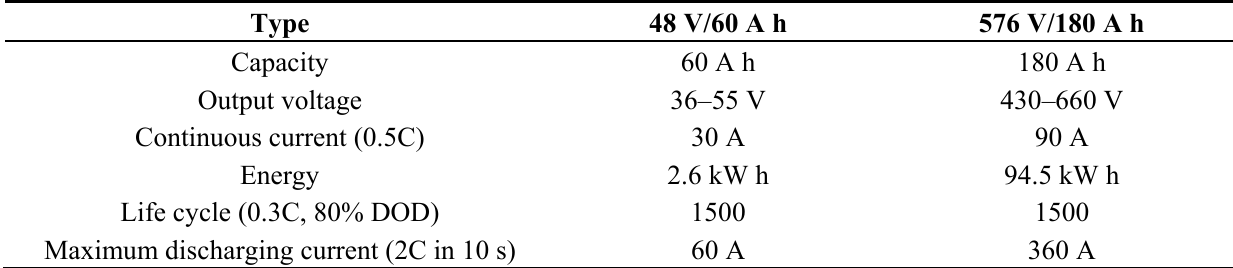
Table 3. Parameters of battery (data extracted from [21]). DOD: depth of